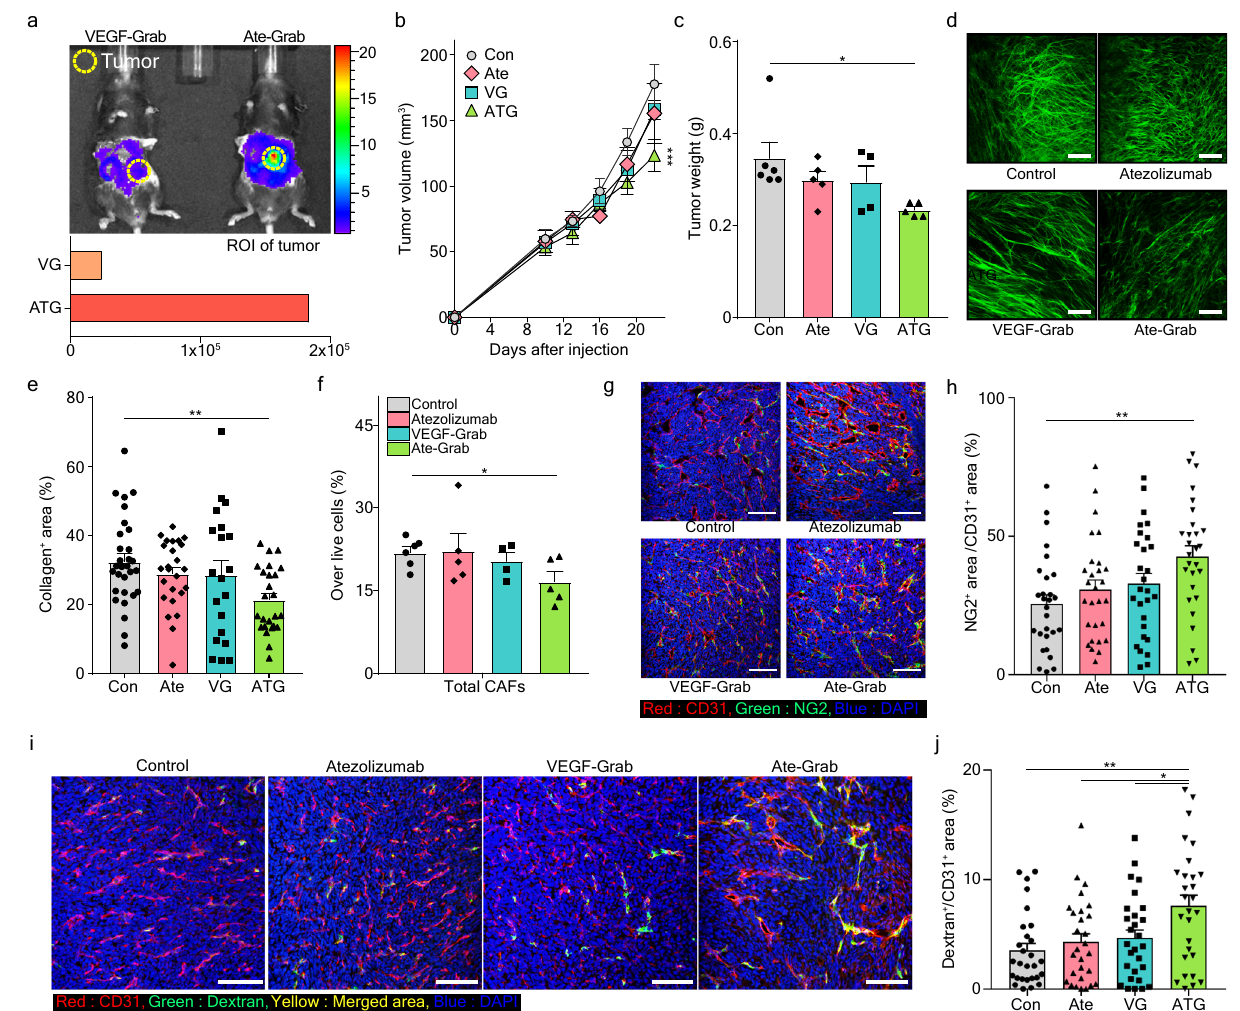
Red : CD31,Green : Dextran,Yellow : Merged area,Blue : DAPI Fig. 4 | PD-L1-directed tumor targeting of Ate-Grab exhibits antitumor and in each treatment-administered Pan02 tumor. PBS (control; n =6), atezolizumab anti- fi brotic effects via regulating CAFs. a In vivo distribution of Cy5.5-con- ( n =5), VEGF-Grab (VG; n =4) or Ate-Grab (ATG; n =5), * P <0.05 ( P =0.029). Two- jugated VEGF-Grab (VG) and Ate-Grab (ATG) in anorthotopic Pan02 tumor model. Fluorescence with overlapped mouse image (up) and quanti fi cation of ROI in the for NG2 (green) and CD31 (red) in Pan02 tumors treated with different agents. tumor (down) are shown. Yellow circle: Tumor mass. b – h When tumor volume Yellow indicates the co-expression of NG2 and CD31. Scale bar, 100 μ m. reached 50 – 100mm 3 , tumor-bearing mice were intraperitoneally treated with either PBS (control; n =6), atezolizumab ( n =5), VEGF-Grab (VG; n =4) or Ate-Grab Data from 28 randomly selected fi elds of view per group were analyzed ( n =28). (ATG; n =5) (10mg/kg, every3 days). b Tumor volumesperiodically monitored via i Representative immuno fl uorescence (IF) images staining for CD31 (red) and abdominal ultrasonography. *** P <0.001 versus control. Two-way ANOVA with Tukey ’ s multiple comparisons. c Tumor weights measured at the end of the Dextran(green)inPan02tumorstreatedwithdifferentagents.Yellowindicatesthe experimental period. * P <0.05 ( P =0.018). Two-tailed Student ’ s t test. co-expressionofCD31andDextran.Scalebar,100 μ m. j Quanti fi cationsofDextran + /CD31 + inIFdatawereanalyzedbyImageJ.Datafrom28randomlyselected fi eldsof d Representative images showing SHG signals of each treatment-administered view per group were analyzed. * P <0.05 (VG vs ATG: P =0.048, Ate vs ATG: Pan02 tumor. e Average percentages of collagen + area out of the total area of tumors treated with the indicated drugs, as quanti fi ed using ImageJ. Data from P =0.021), ** P <0.01 (Con vs ATG: P =0.002), One-way ANOVA with Tukey ’ s mul- randomly selected fi elds of view were analyzed (Con, n =25; Ate, n =28; VG, n =21; tiple comparisons. All error bars in this fi gure are presented as the mean±SEM. ATG, n =29). ** P <0.01 ( P =0.009) versus control. One-way ANOVA with Tukey ’ s Source data are provided as a Source Data fi multiplecomparisons. f FlowcytometryanalysisshowingpercentagesoftotalCAFs